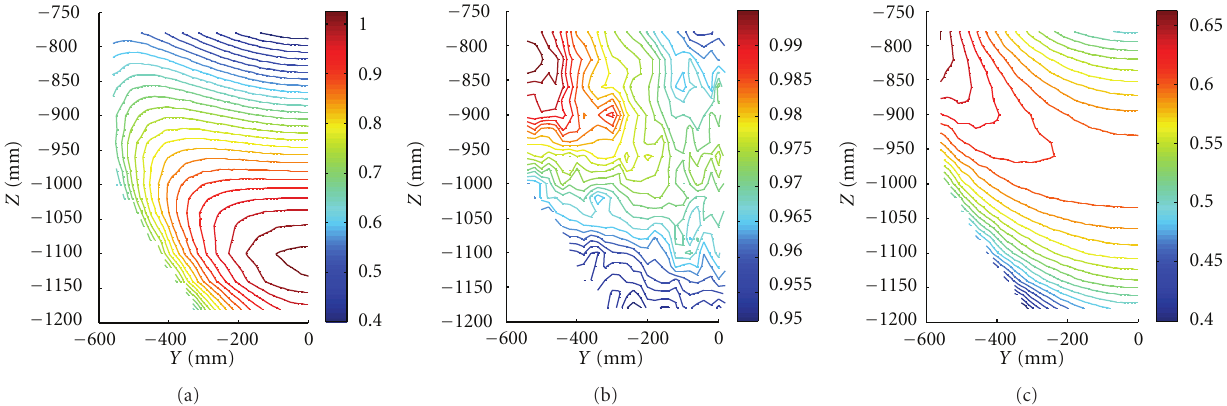
Figure 20: Manipulability index μ t (a), normalized velocity along the Z direction (b), and DSI μ Z computed in the vertical half-plane XZ with X = 100mm (c).